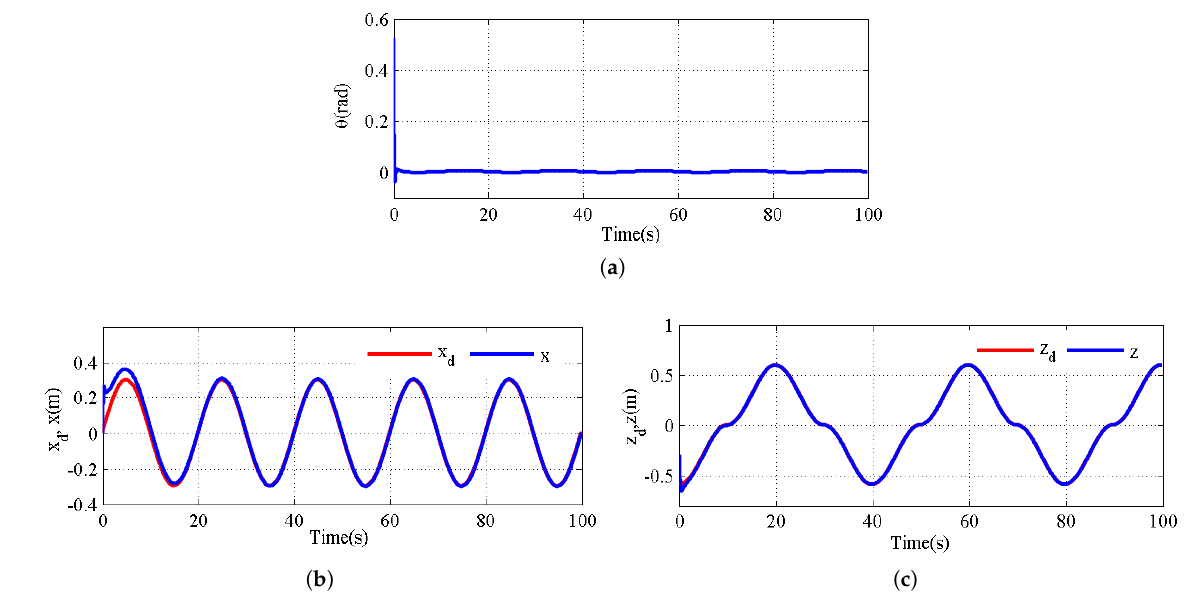
Figure 5. The state variables. ( a ) The angle θ ; ( b ) the desired x d and x ; and ( c ) the desired z d and z .